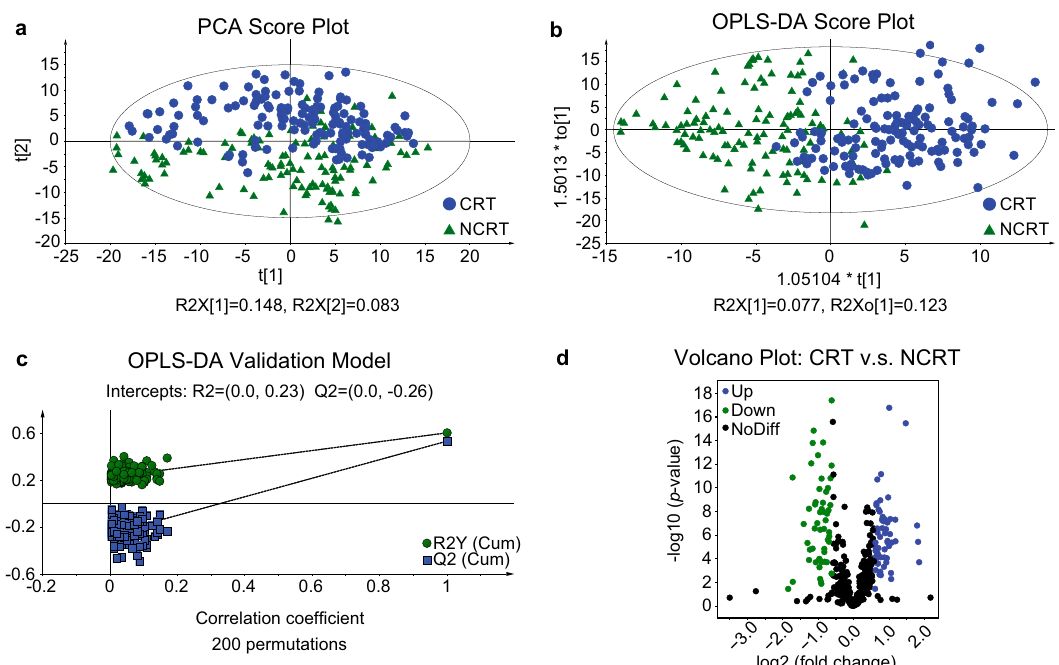
Fig. 2 Multivariate statistical analysis of volatile metabolites of CRT and NCRT Wuyi rock tea samples. a PCA score plot. b OPLS-DA score plot. R 2 Y cum = 0.602, Q 2 cum = 0.532. c Cross-validation plot of the OPLS-DA model with 200 permutation tests. d Volcano plot showing differential metabolites. Blue dots represent fold-change >1.5 and p < 0.05. Green dots represent fold-change <0.67 and p < 0.05. Black dots represent no statistically signi fi cant